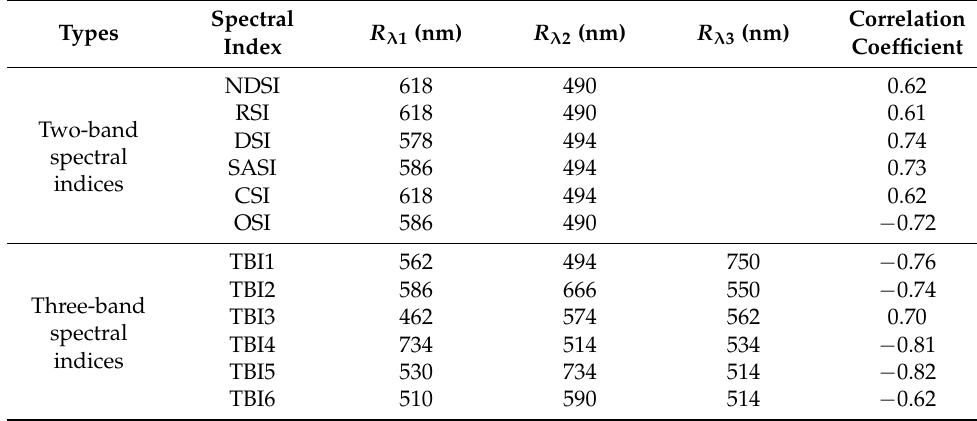
Figure 3. Correlation coefficient between PNC and two-band spectral indices. ( a ) normalized difference spectral index, ( b ) ratio spectral index, ( c ) difference spectral index, ( d ) soil-adjusted spectral index, ( e ) chlorophyll spectral index, and ( f ) optimal spectral index. Table 4. Sensitive wavelength of the three spectral